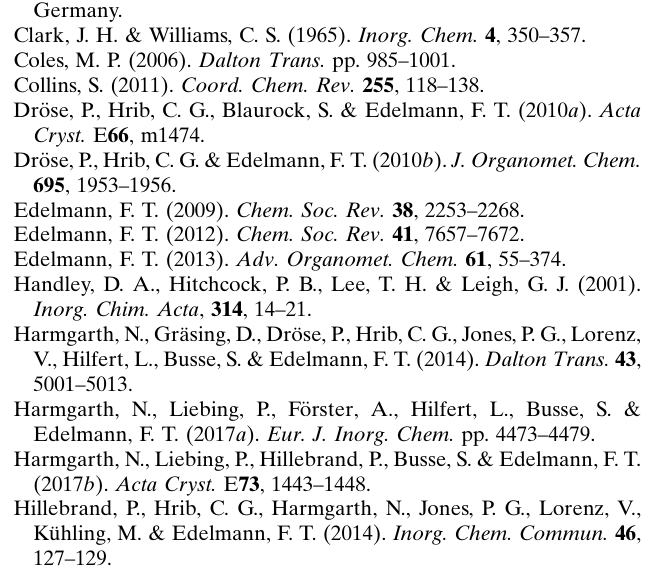
Crystal data Chemical